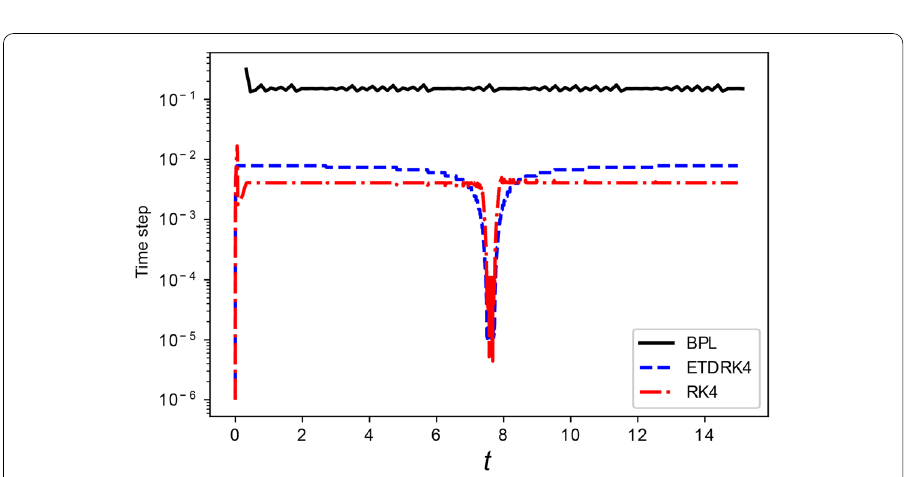
Fig. 16 Evolution of the time step with time Table3 Time step, error and CPU time over one period, with d = 128 BPL ETDRK4 RK4 Mean time step 1 . 53 · 10 − 01 6 . 41 · 10 − 04 1 . 88 · 10 − 03 L 2 error at t = T 9 . 76 · 10 − 06 1 . 10 · 10 − 05 1 . 69 · 10 − 05 Simulation time 1.74 1 . 66 · 10 + 03 5 . 98 · 10 +